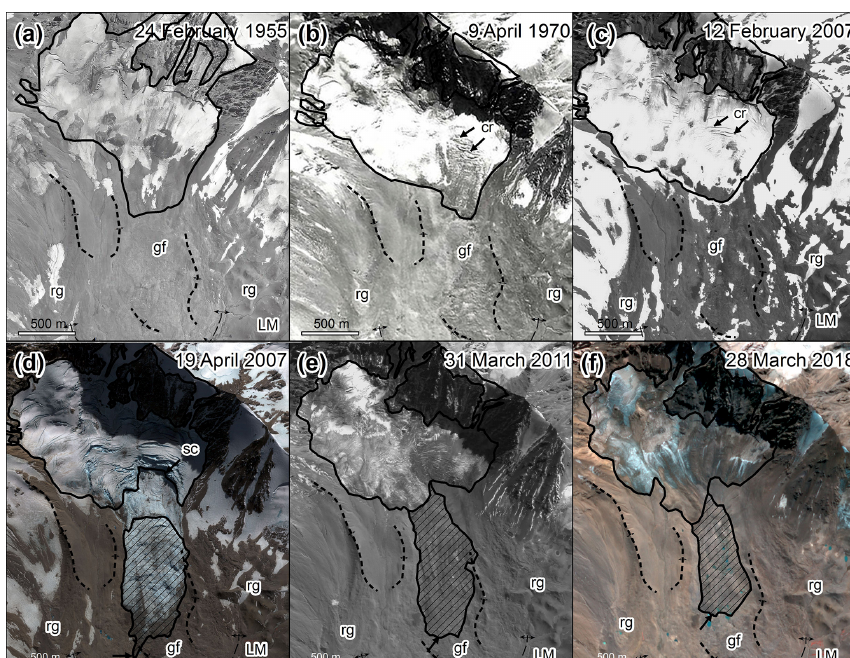
Figure 2. Evolution of the Leñas Glacier (black line) and avalanche deposit extent through time. (a, b) Aerial photos and (c) SPOT 5 show the glacier’s slight retreat before collapse. The large crevasses visible in 1970 (b) and February 2007 (c) demark the location of the scarp head in the QuickBird scene of 19 April 2007 (d) . (e) ALOS PRISM and (f) Planet RGB 432 depict the growth of debris-covered portions on the glacier and the transformation of the collapse deposits. The black arrow shows the distal terminus of the avalanche deposit. gf: glacier forefield; LM: LIA moraine; rg: rock glacier; cr: crevasse; sc: avalanche